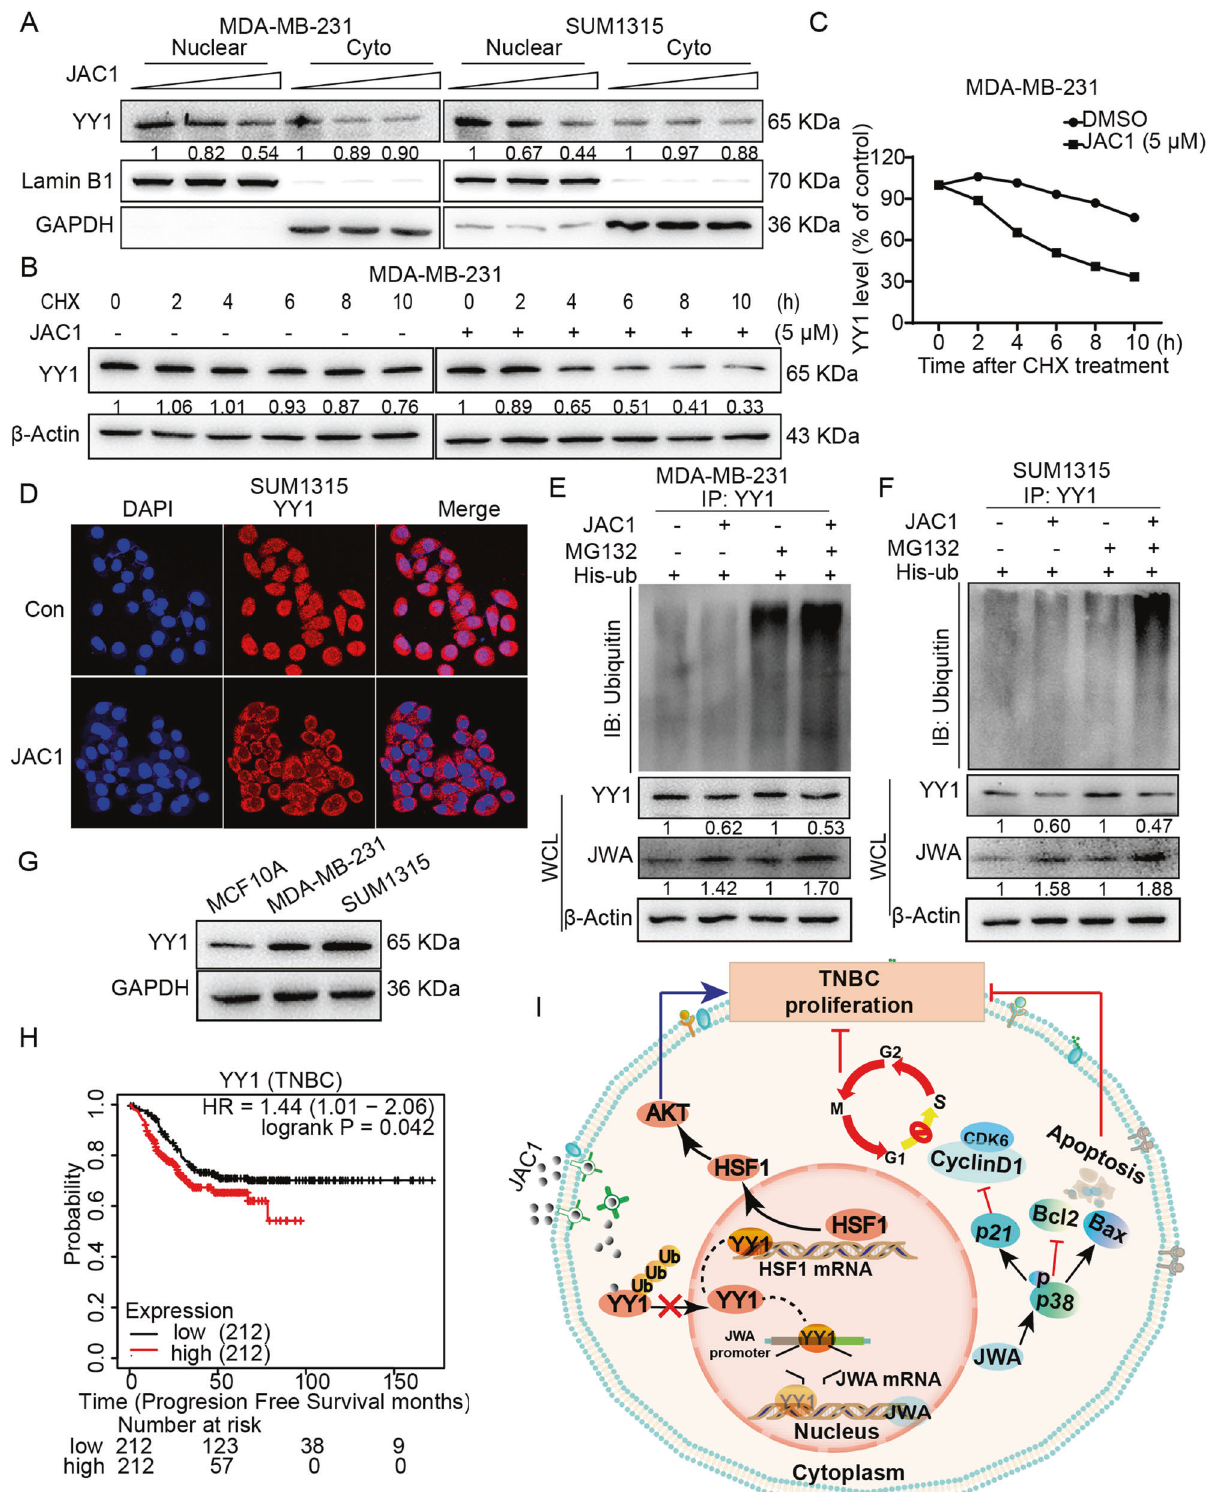
YY1 ubiquitin modi fi cation and degradation. However, the behind mechanisms which JAC1 induced YY1 ubiquitination still needs to clarify. Although the E3 ubiquitin ligase Smurf2 is reported to target and degrade YY1 protein in several cancers [43], unfortunately, we did not obtain positive evidence of Smurf2 on YY1 in